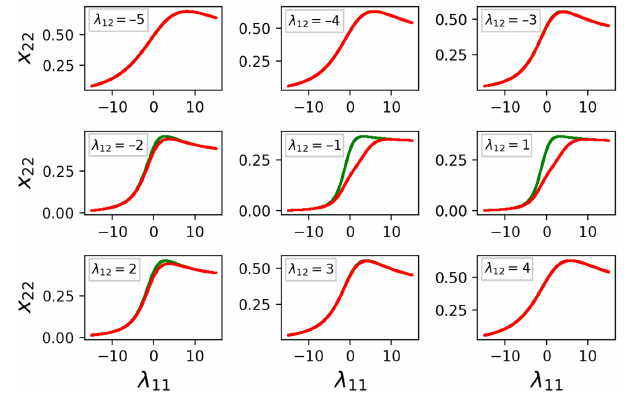
FIG. 8. Red curve shows a plot between the true values of x 22 and λ 11 for various values of λ 12 , whereas the green curve shows a plot between the predicted values of x 22 from the reconstructed density matrix and λ 11 for the same value of λ 12